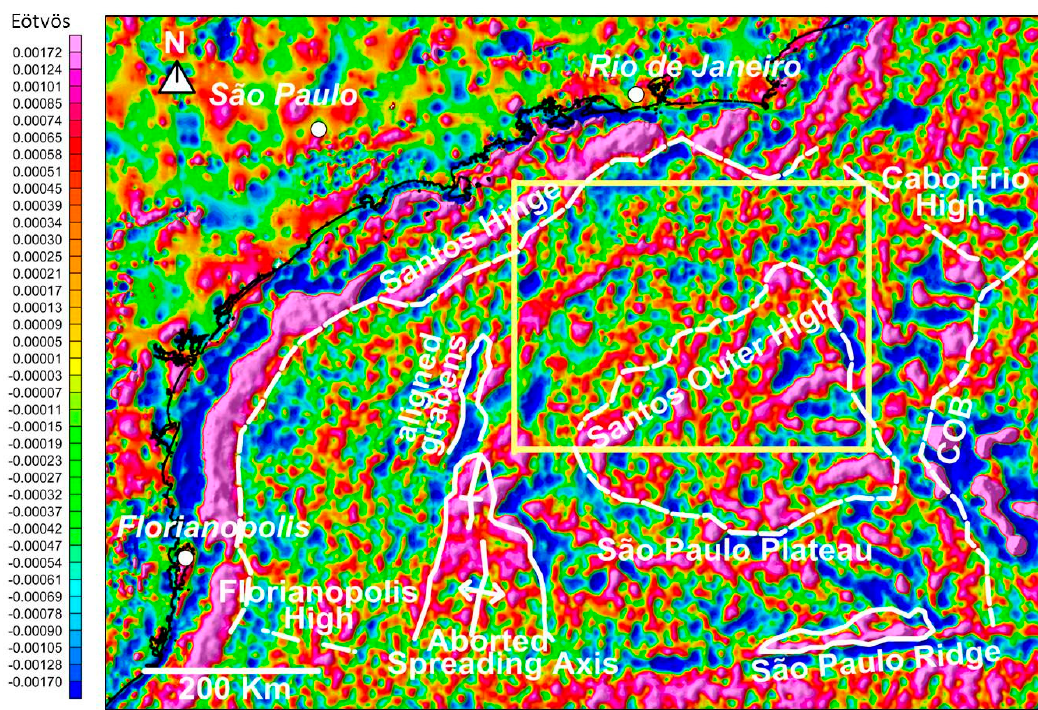
Figure 4. Residual Bouguer anomaly map. The blue areas correspond to the minimum gradients whereas the red and pink correspond to the maximum gradient areas of the residual anomalies. The yellow rectangle corresponds to the area studied in detail. COB corresponds to the continent–ocean boundary.